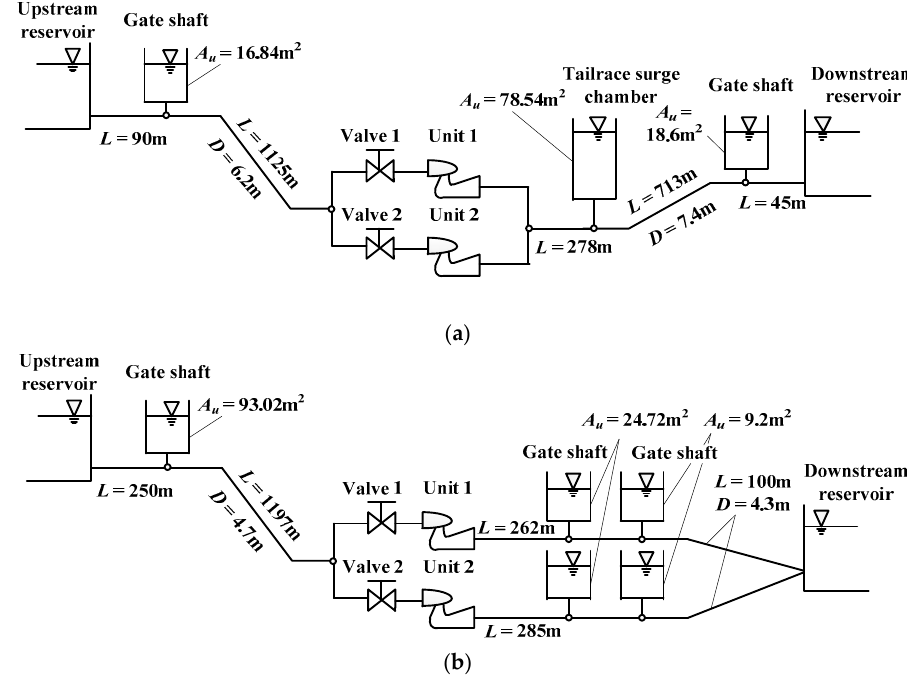
Figure 11. Schematic diagram of piping layout. ( a ) Xianju PSPP; ( b ) Xilongchi PSPP. Table 5. The main characteristics of the Xianju and Xilongchi PSPPs.